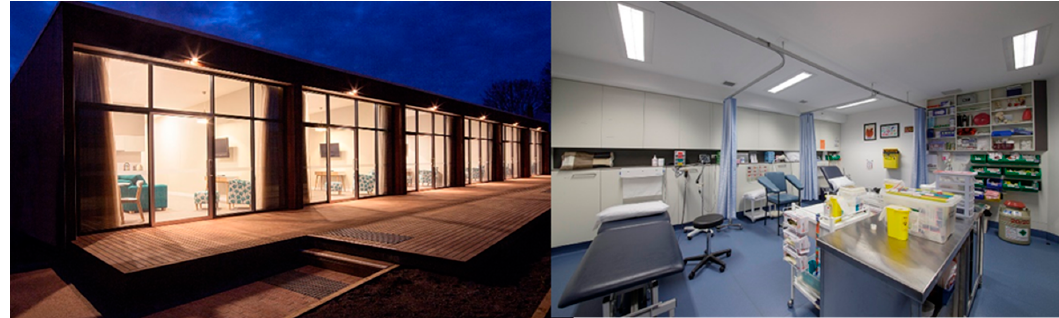
Figure 4. Images from healthcare facilities built using modular construction in Australia, Left—Ballarat Health Cancer Care Unit, Right—Pascoe Vale Health (Prebuilt Pty. Ltd., 2018)